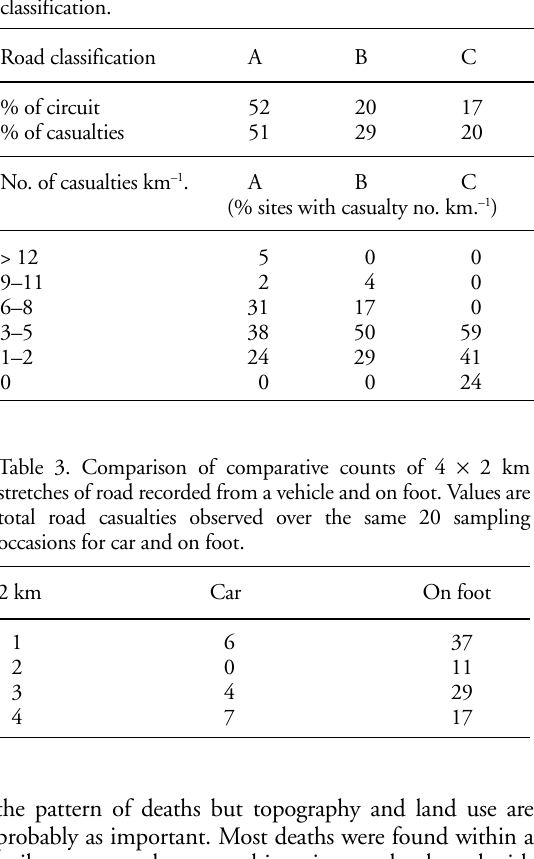
Table 2. Percentage of total road casualties expressed by road classification.